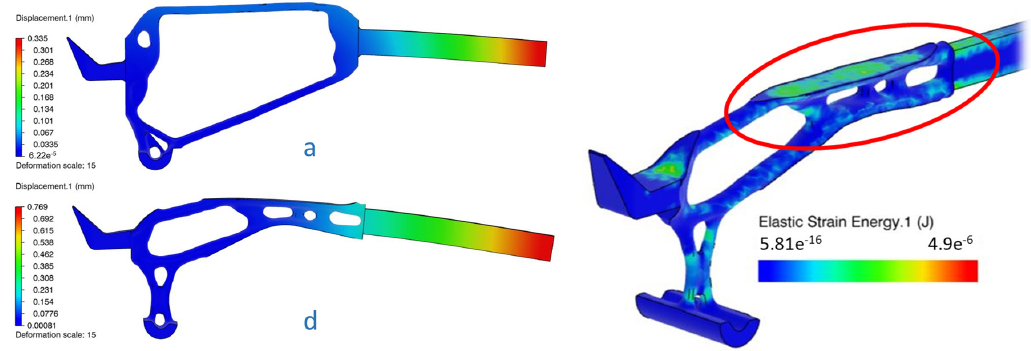
Figure 9. Deformation of concepts ( a ) and ( d ) and elastic strain energy of concept ( d ).